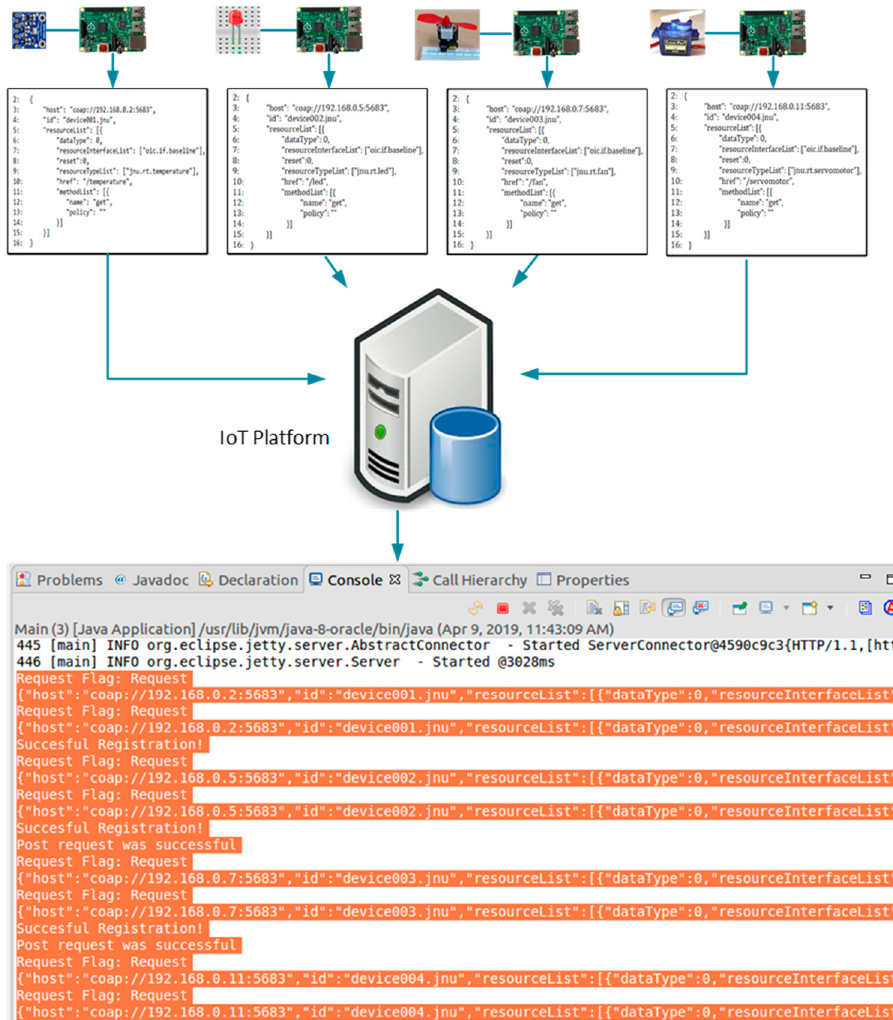
Figure 11. IoT device auto-registration result.